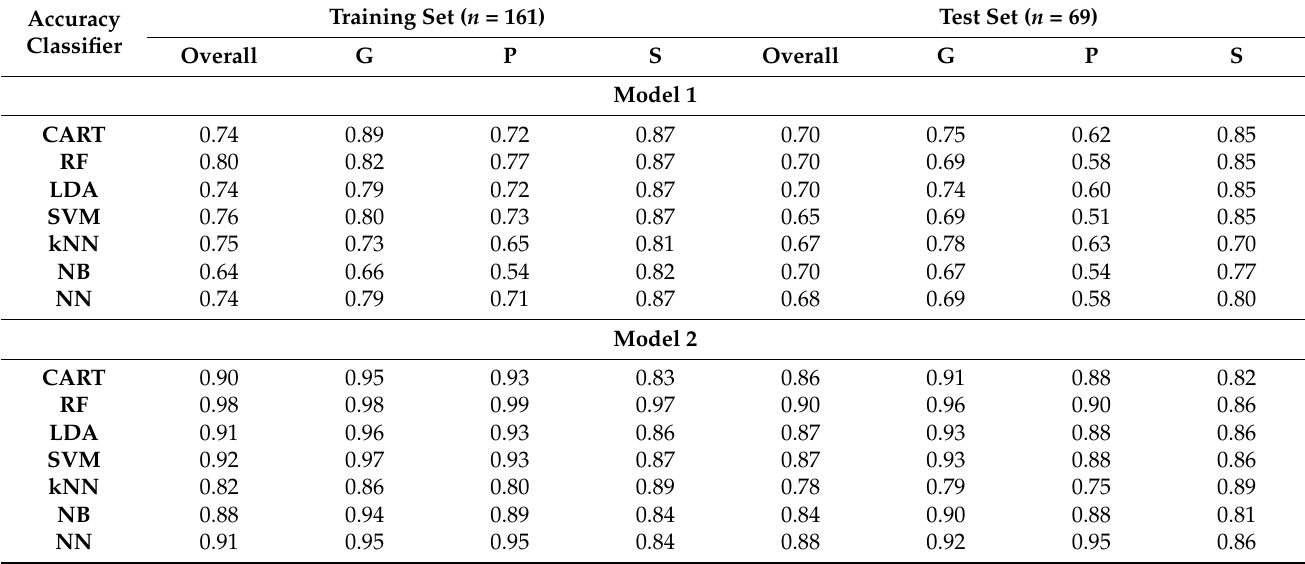
Table 2. Predicted value according to machine learning algorithm using initial blood test results (Model 1) and including thyroid antibody test results (Model 2).